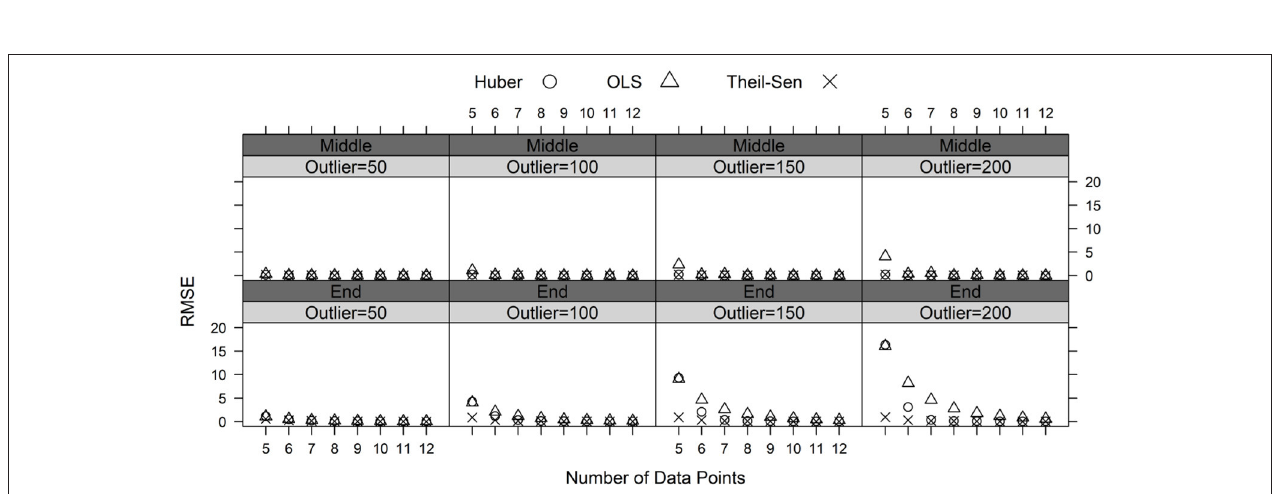
FIGURE 4 | RMSE for the estimated slopes by the magnitude of the outlier (50, 100, 150, and 200 points) and the position of the outlier (middle and end) in the progress monitoring data.